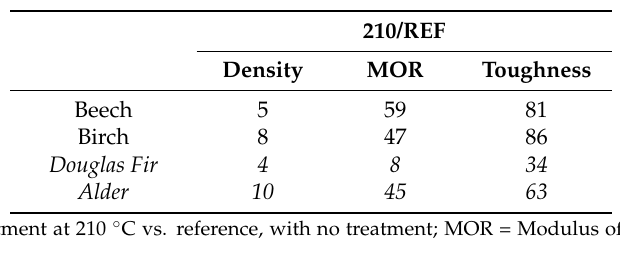
Table 7. Percentage Decrease in Wood Property of Heat-treated Wood in Comparison to the Reference (untreated)